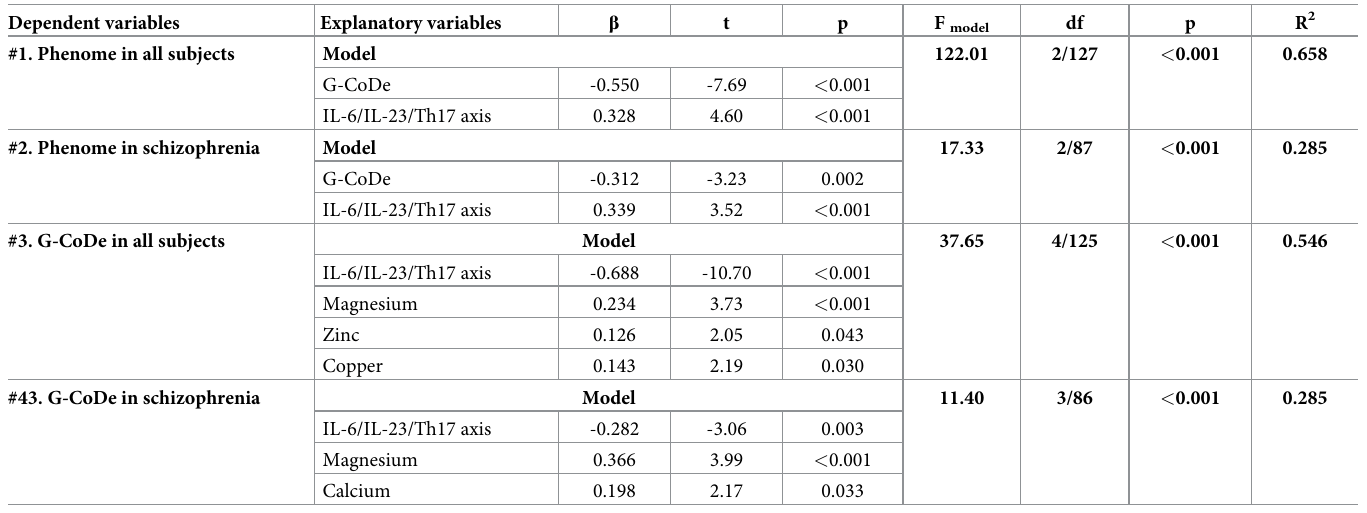
Table 4. Results of multiple regression analyses with the phenome of schizophrenia or the generalized cognitive decline (G-CoDe) score as dependent variables and biomarkers as explanatory variables. Dependent